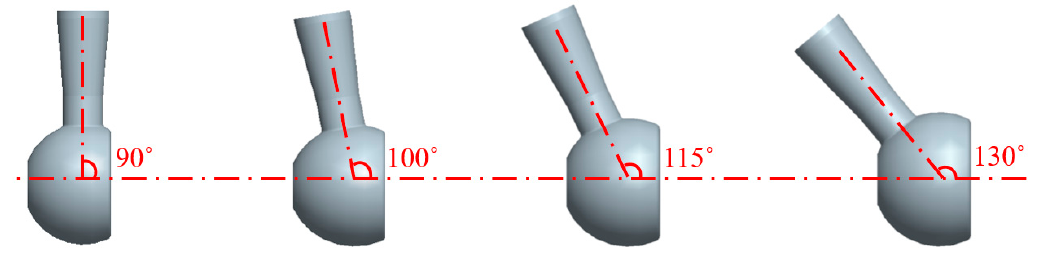
ff erent outlet pipe Figure 2. Pump Casings with different outlet pipe angles. Figure 2. Pump Casings with different outlet pipe angles. Figure 2. Pump Casings with di